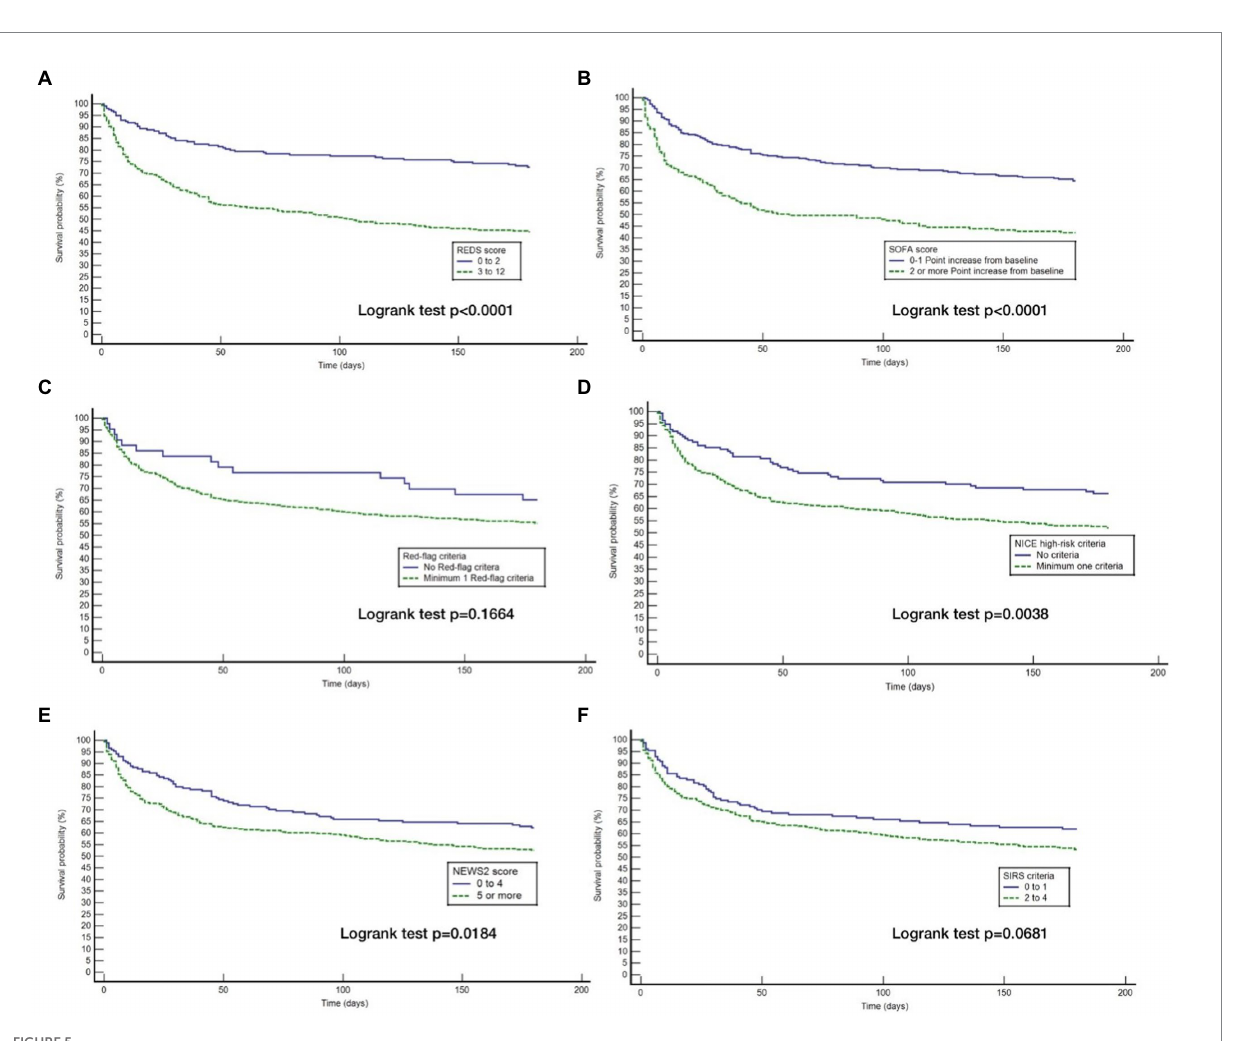
FIGURE 5 Kaplan Meier curves for 180 day survival for those with specified* co-morbidities stratified by the different tools. (A) Kaplan Meier curves for 180 day survival as stratified by the REDS score; (B) Kaplan Meier curves for 180 day survival as stratified by the SOFA score; (C) Kaplan Meier curves for 180 day survival as stratified by the Red = flag criteria; (D) Kaplan Meier curves for 180 day survival as stratified by the NICE criteria; (E) Kaplan Meier curves for 180 day survival as stratified by the NEWS2 score; (F) Kaplan Meier curves for 180 day survival as stratified by the SIRS criteria. *Specified comorbidities = presence of any one of the following: dementia, malignancy, care home residency or a minimum three times a day care package, on long-term oxygen therapy (LTOT) or a previous do-not-resuscitate